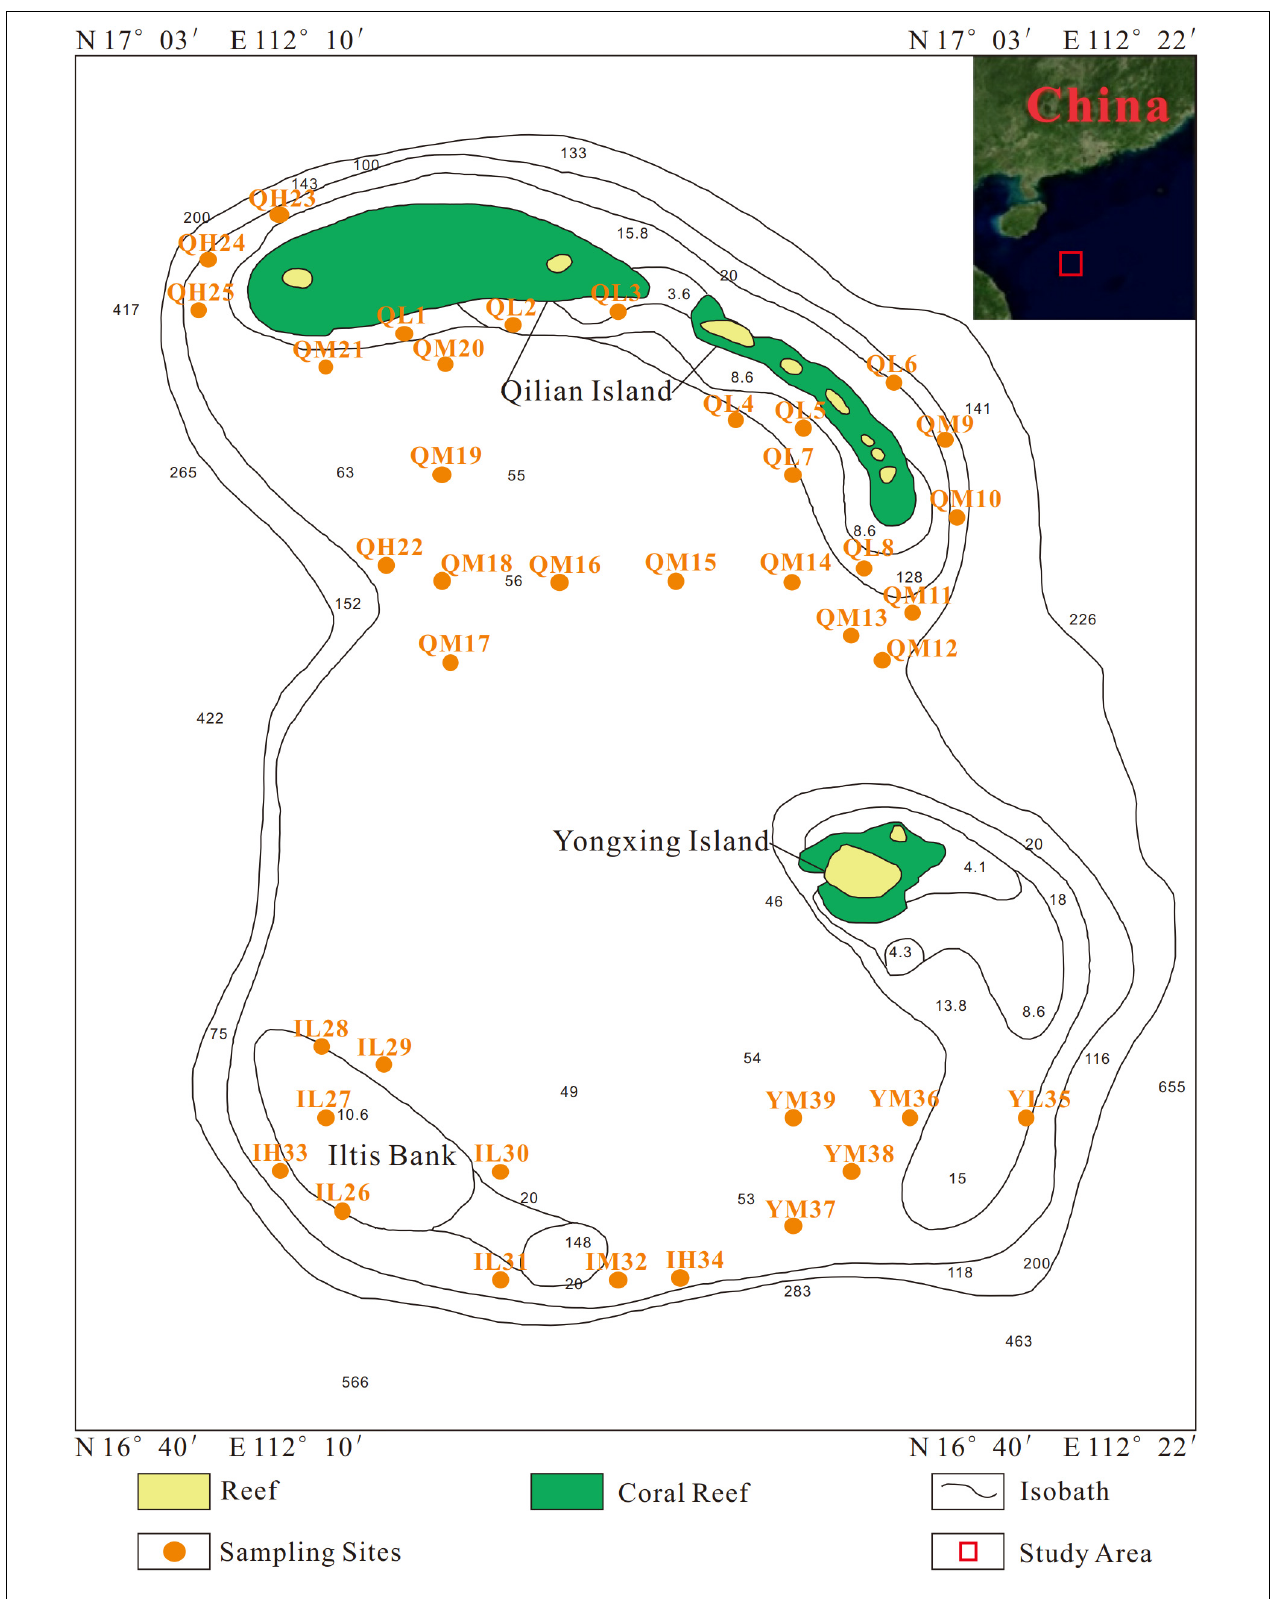
FIGURE 1 | Sampling sites of all sediment